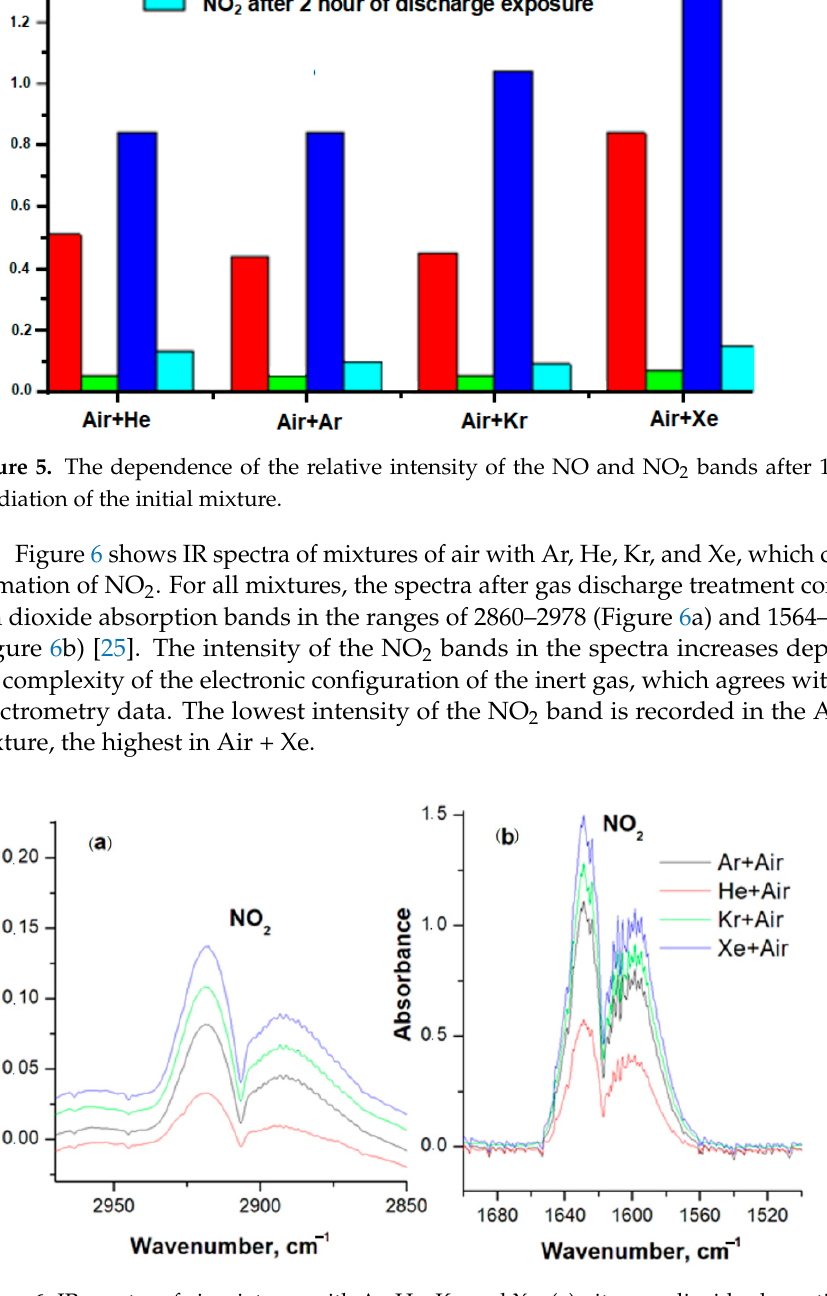
Figure 6. IR spectra of air mixtures with Ar, He, Kr, and Xe. ( a ) nitrogen dioxide absorption bands in the ranges of 2860–2978 cm − 1 ; ( b ) nitrogen dioxide absorption bands in the ranges of 1564–1650 cm − 1